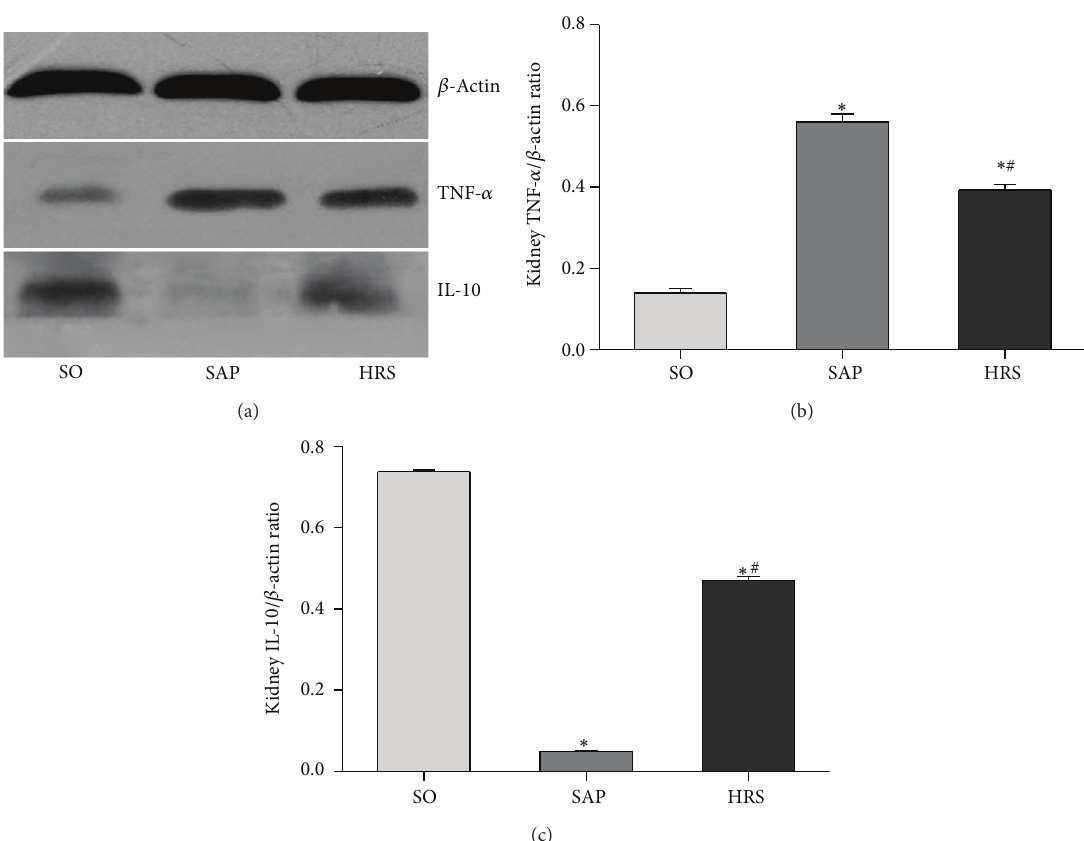
Figure 8: Western blotting for measuring the expression of TNF- 𝛼 and IL-10 by using extract of renal total proteins at 12 hours. (a) Levels of TNF- 𝛼 and IL-10 in renal total proteins. (b) and (c) Densitometric analysis of the bands for the ratios of TNF- 𝛼 / 𝛽 -actin and IL-10/ 𝛽 -actin. Results are expressed as mean (SD), 8 rats per group. ∗ 𝑃 < 0.05 versus respective SO group; # 𝑃 < 0.05 versus respective SAP group.